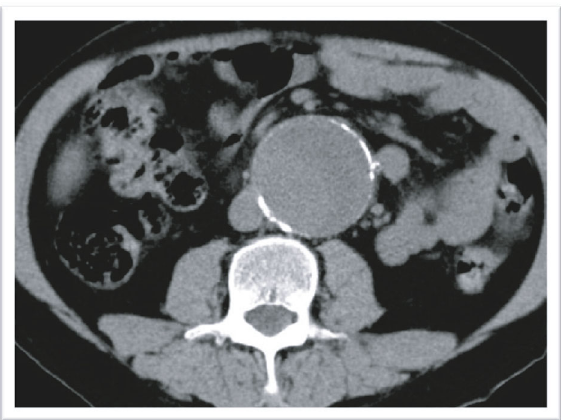
Figure 3: Abdominopelvic CT scan without contrast before AAA repair